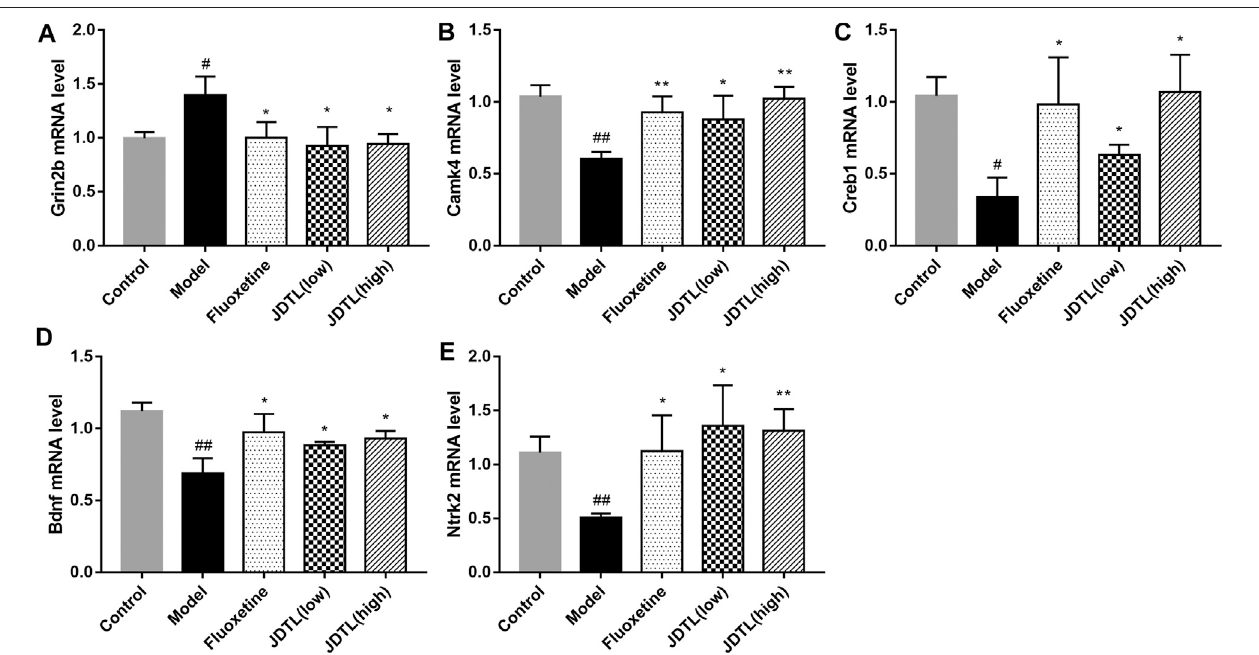
FIGURE 8 | Gene Expressions of NMDAR/BDNF Pathway in Ipsilateral Cortex. (A – E) Relative mRNA levels of Grin2b, Camk4, Creb1, Bdnf, and Ntrk2 in the brain tissue. Data are described as mean ± SD, n (cid:2) 3. ## p < 0.01, # p < 0.05 vs Control group, ** p < 0.01, * p < 0.05 vs Model